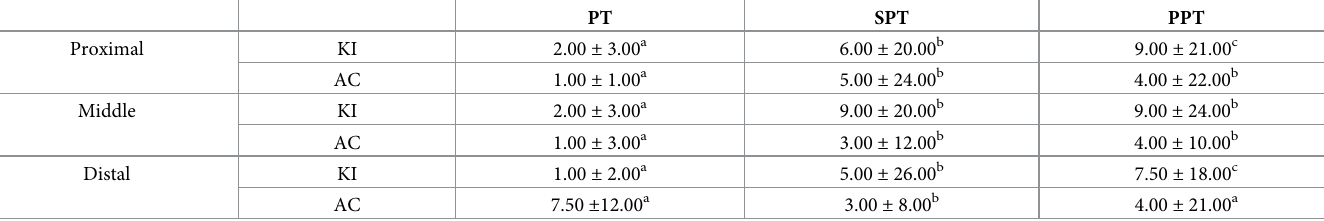
Table 4. Proliferative activity of stem cells of the intestinal crypts of the intestinal mucosa epithelium (KI—Ki67 positive cells) and apoptosis of intestinal villi epi- thelial cells in the mucosa (AC—apoptotic cells) in the proximal, middle, and distal segments of the small intestine in preterm piglets.